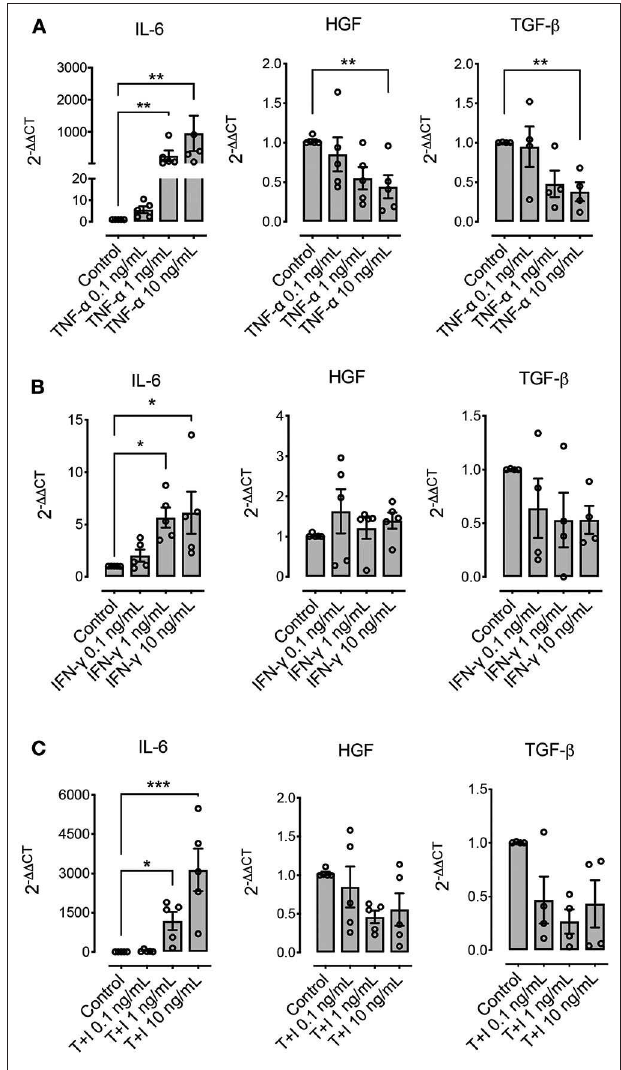
FIGURE 5 | Pre-conditioning modulates the expression of immunomodulatory genes in MSCs. The effect of pre-conditioning equine bone marrow-derived MSCs during 24h with TNF- α (A) , IFN- γ (B) or their combination (C) on the expression of interleukin 6 (IL-6), hepatocyte growth factor (HGF), and transforming growth factor β (TGF- β ) (* p < 0.05, ** p < 0.01, *** p < 0.001; n = 4 or 5 since we were unable to determine the basal expression of TGF- β in one